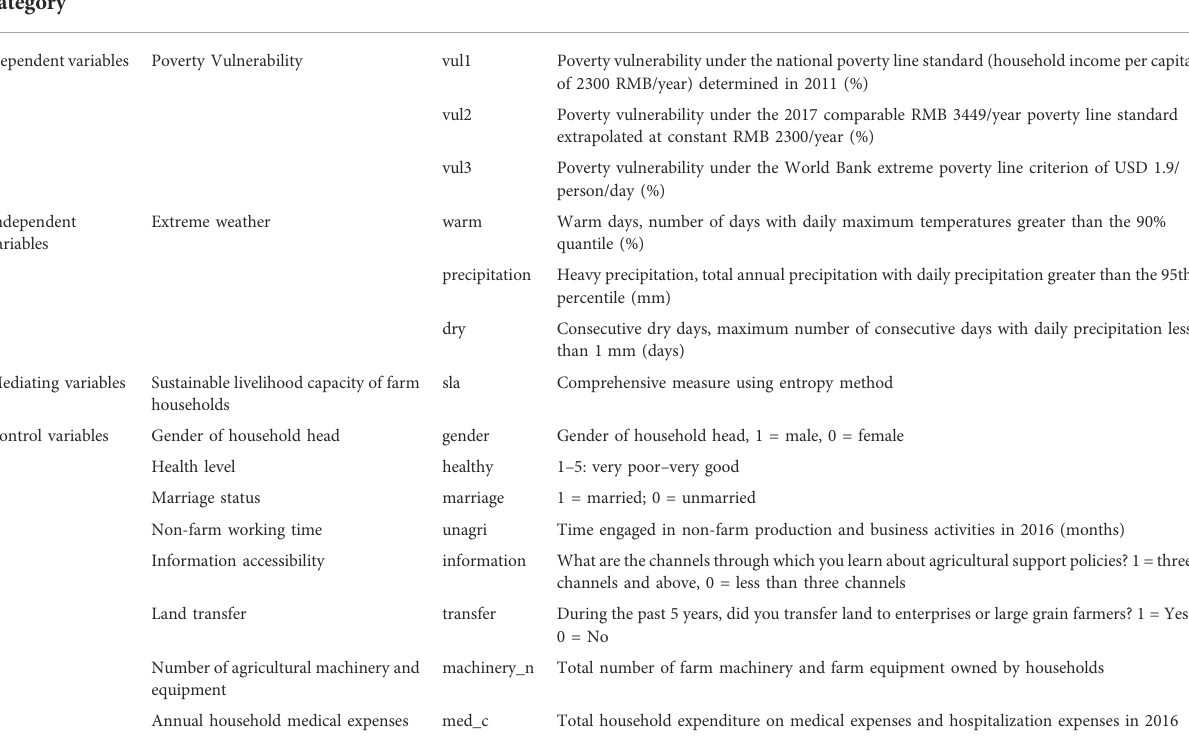
TABLE 3 Names and de fi nitions of relevant